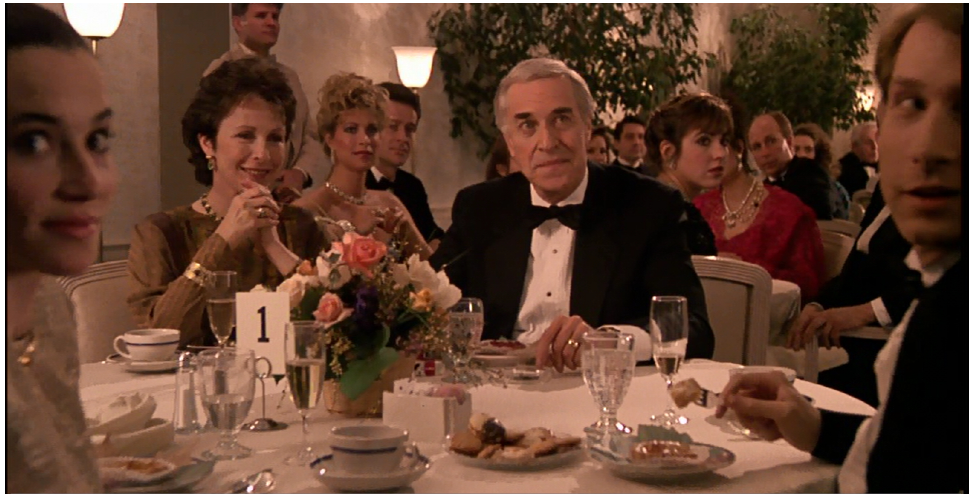
Figure 1: Judah Rosenthal (Martin Landau) with his wife Miriam (Claire Bloom), daughter Sharon (Stephanie Roth, front left) and Sharon’s fiancé, Chris (Gregg Edel- man, front right). All stills are from the DVD of Crimes and Misdemeanors (Allen 2004